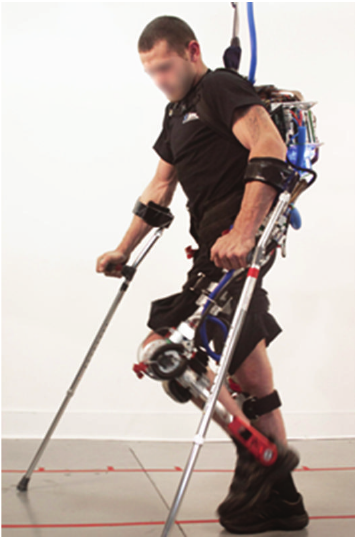
Figure 6: The Mina during